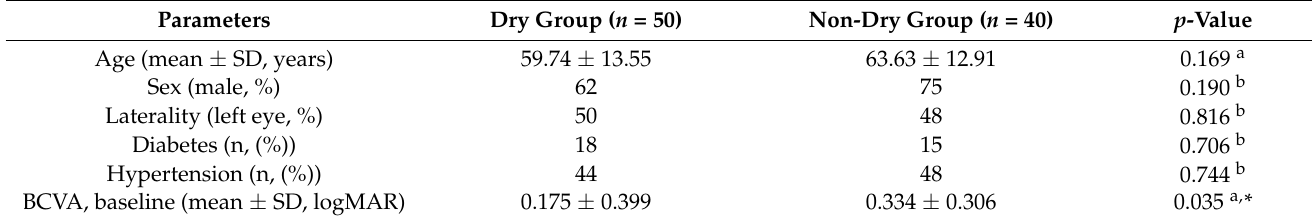
Table 1. Comparison of clinical characteristics between dry and non-dry PNV